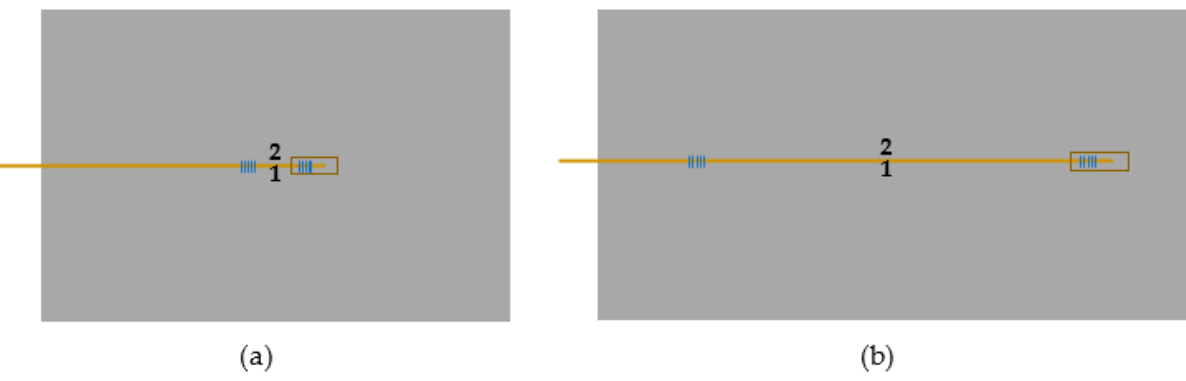
Figure 4. Schematic of approximate impact locations on specimens containing ( a ) SDOF and ( b ) LDOF. Numbers 1 and 2 represent the locations of the first and second impacts, respectively.